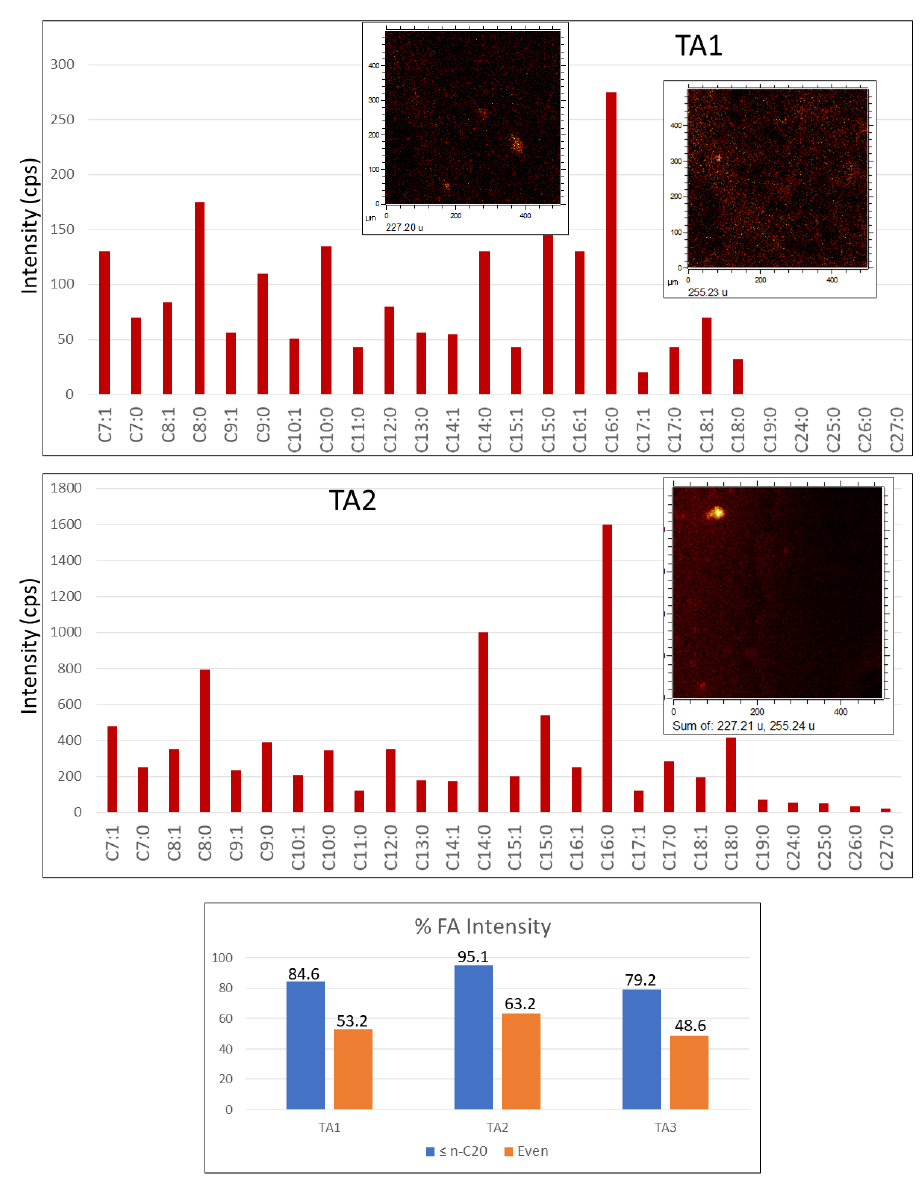
Figure 8. Bar diagrams plotting the mass distribution of saturated and monounsaturated fatty acids in TA1 and TA2. The lower diagram draws a high abundance for ≤ n-C20, moderate for even FA chains supporting a microbial origin for the organic compounds. Diagram units are expressed as count per second (cps) intensity unit. The ToF-SIMS images were obtained from a rasterized surface area of a 500 μ m square.